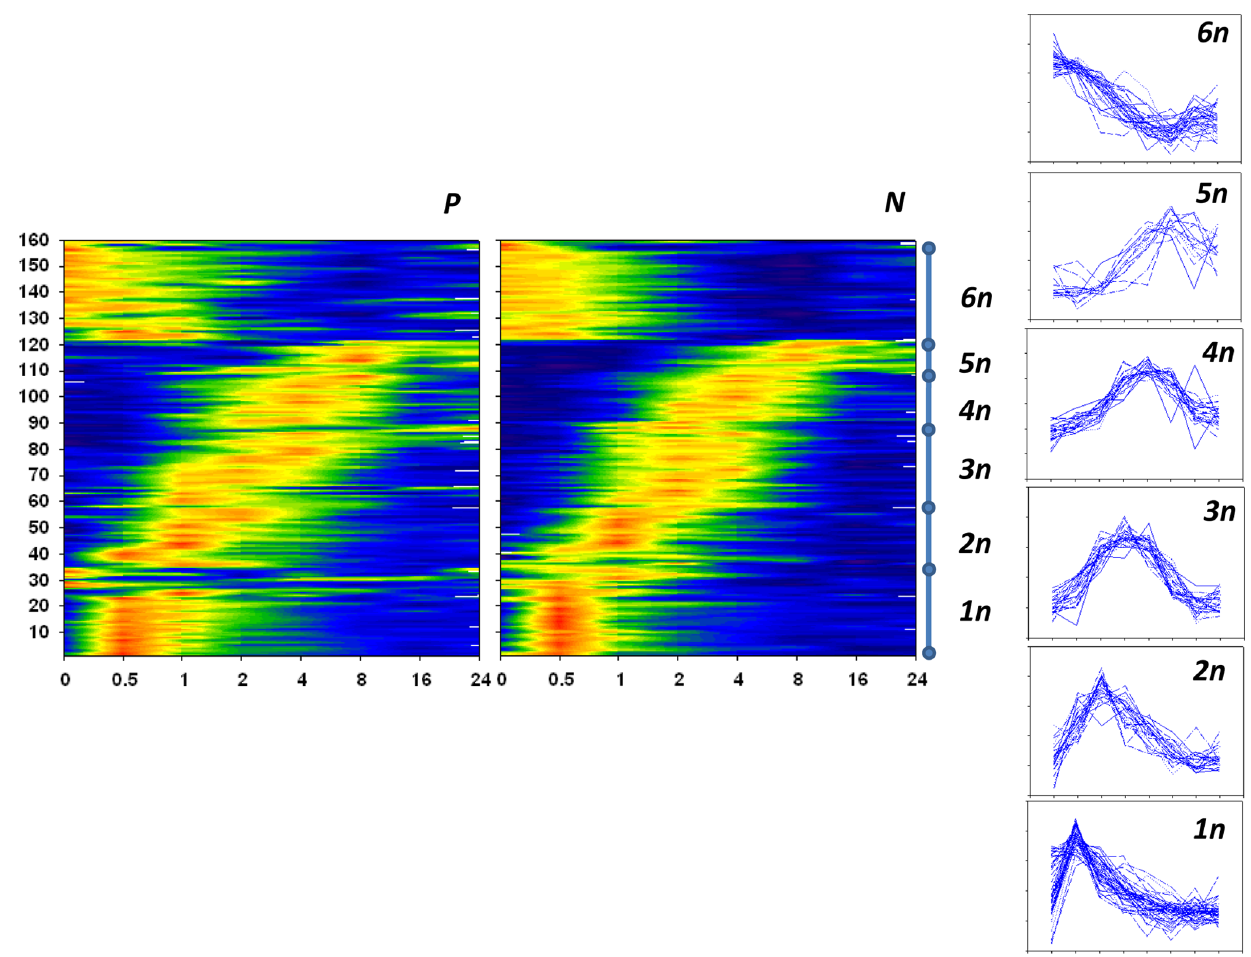
Figure 3. Variable gene clustering after stimulation of B cells from lupus patients and controls. Normalized gene expression data (average=0, standard deviation=1) from stimulated hyperresponsive B cells from SLE patients (left) and normal response B cells from control (right). Blue indicates negative normalized expression data and red indicates positive normalized expression data. Six gene clusters and the corresponding cluster profiles are shown to the right side of the